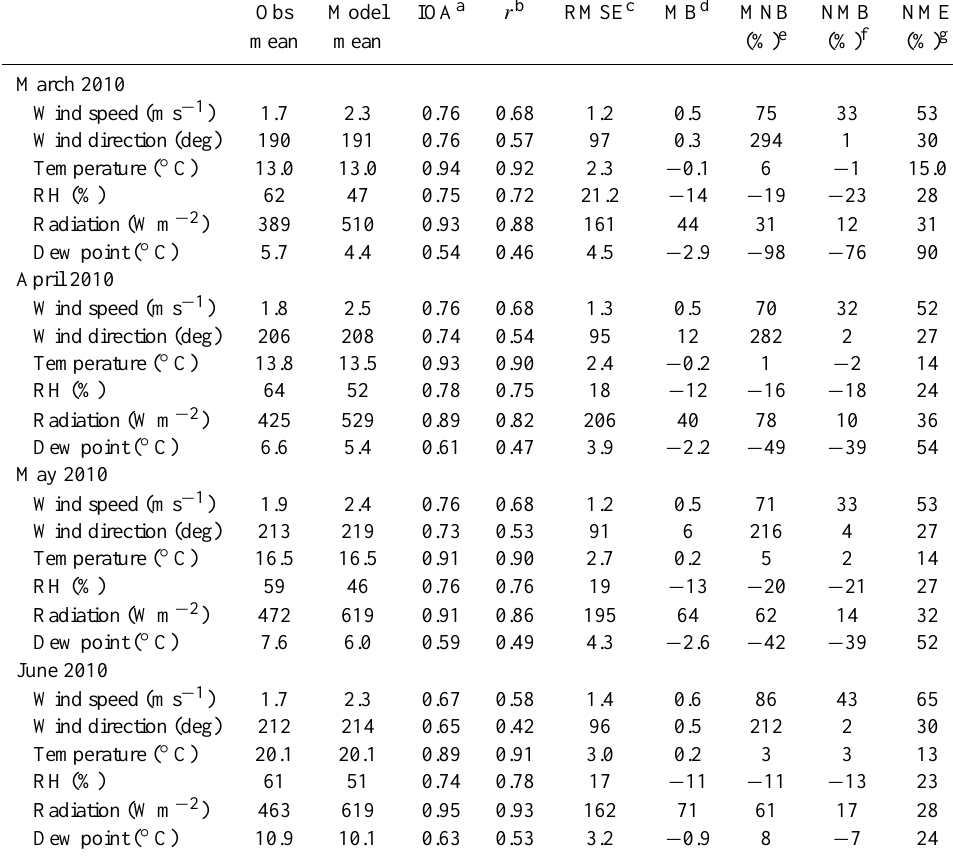
Table 3. Performance statistics of monthly averages for 4km southern California WRF